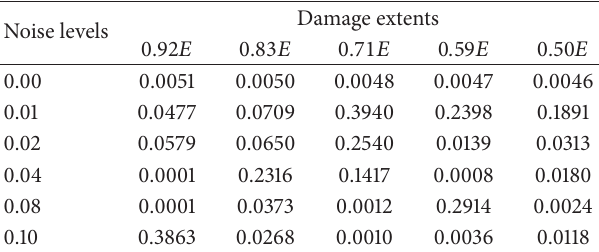
Table 5: The MAC values of stain damage parameter vector extracted from different load